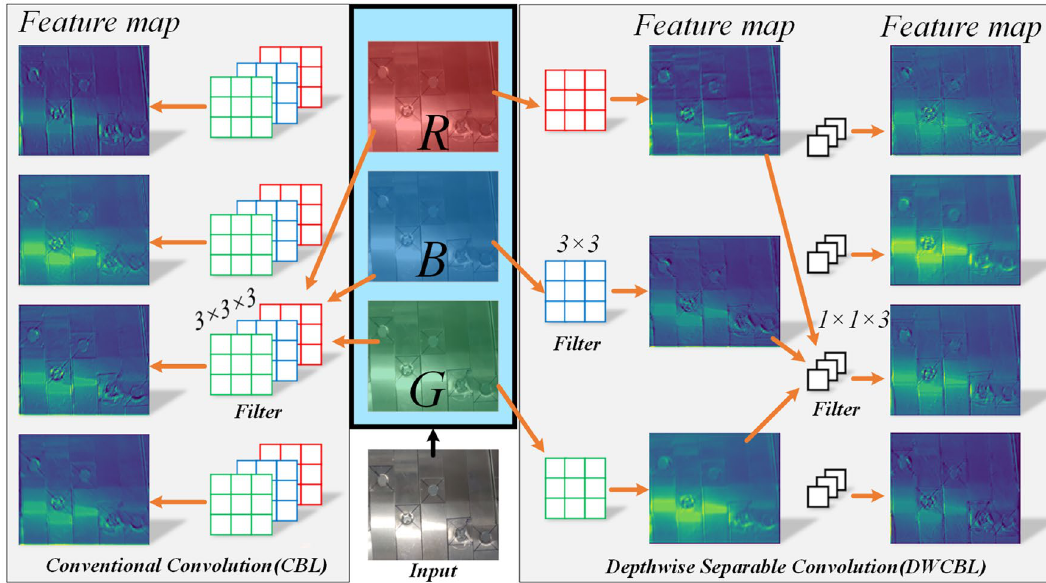
Figure 6. Depth separable convolution differs from conventional